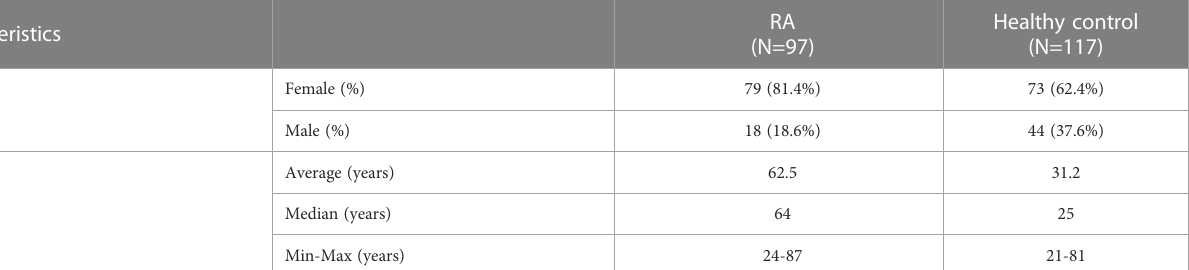
TABLE 1 Characteristics of patients with RA and healthy controls.